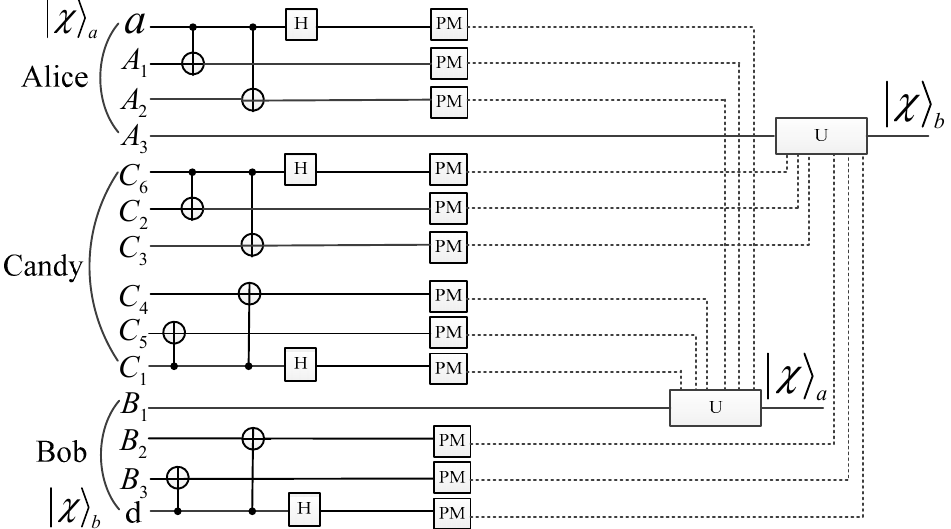
Figure 4. Quantum circuit for two-hop bidirectional quantum communication.